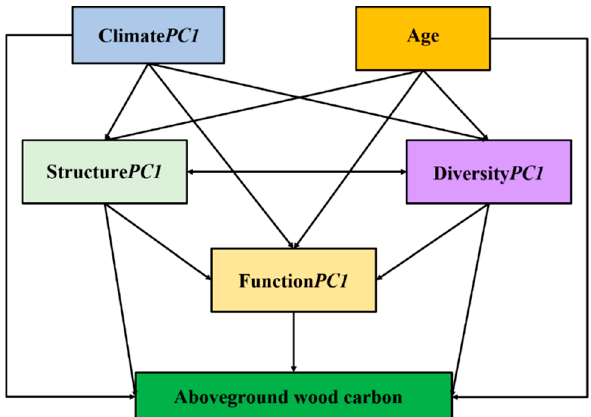
Figure 2. Conceptual models indicating how diversity PC1 , structure PC1 , function PC1 , stand age and climate PC1 affect aboveground wood carbon. PC1 refers to the first principal component of the results of principal component analysis.